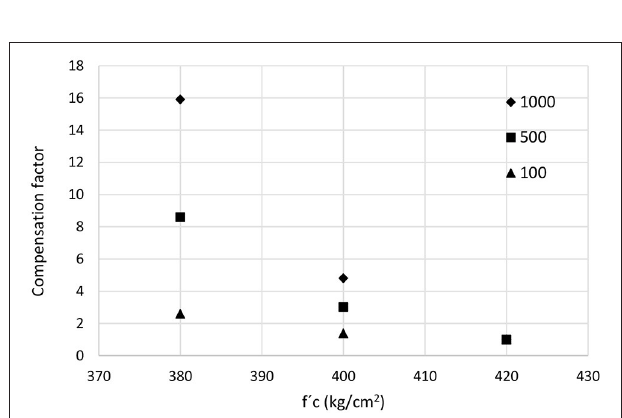
FIGURE 16 | Compensation factors for several actual values of f ′ c, several losses levels, H = 8m and nominal f ′ c = 420 Kg/cm 2 ,